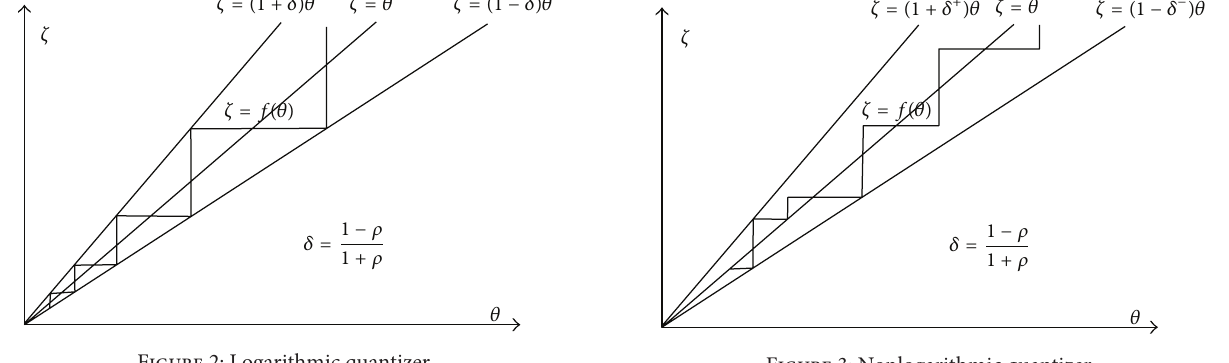
Figure 2: Logarithmic quantizer. Figure 3: Nonlogarithmic